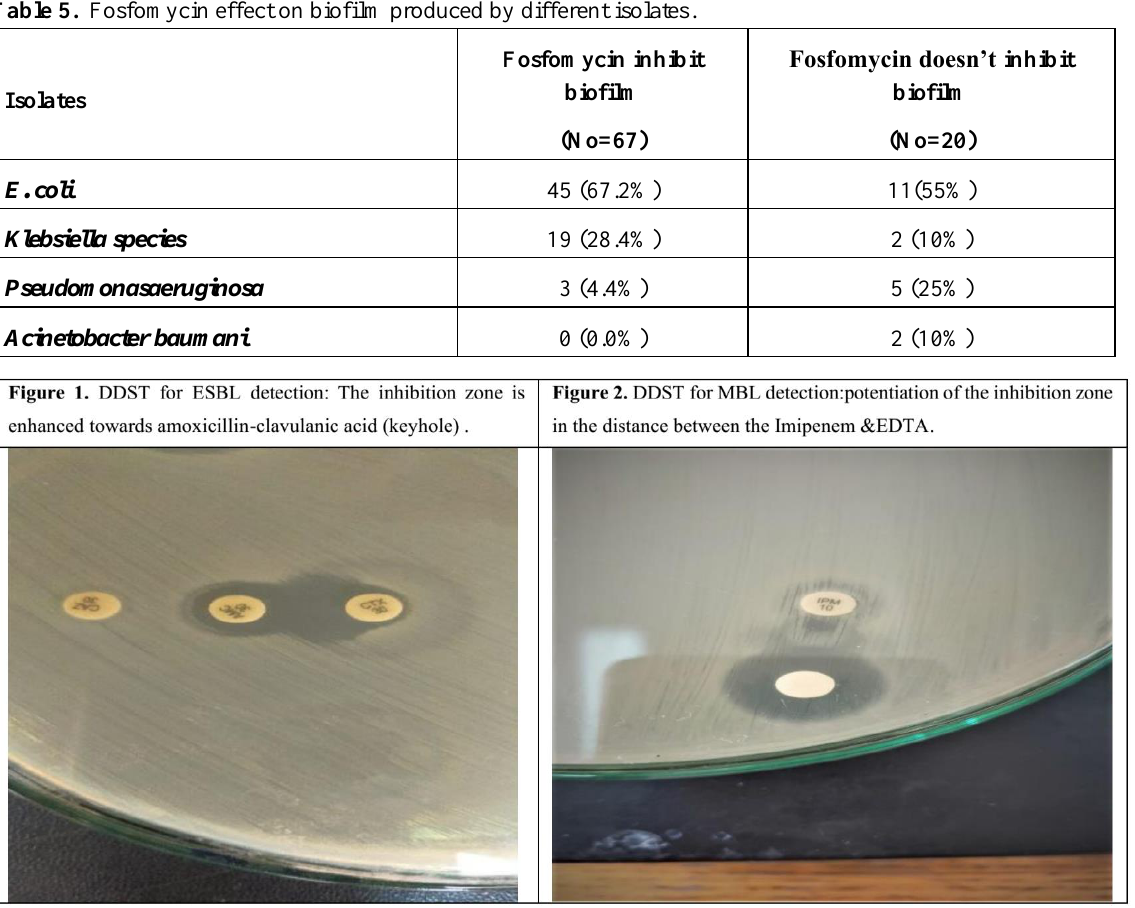
Table 5. Fosfomycin effect on biofilm produced by different